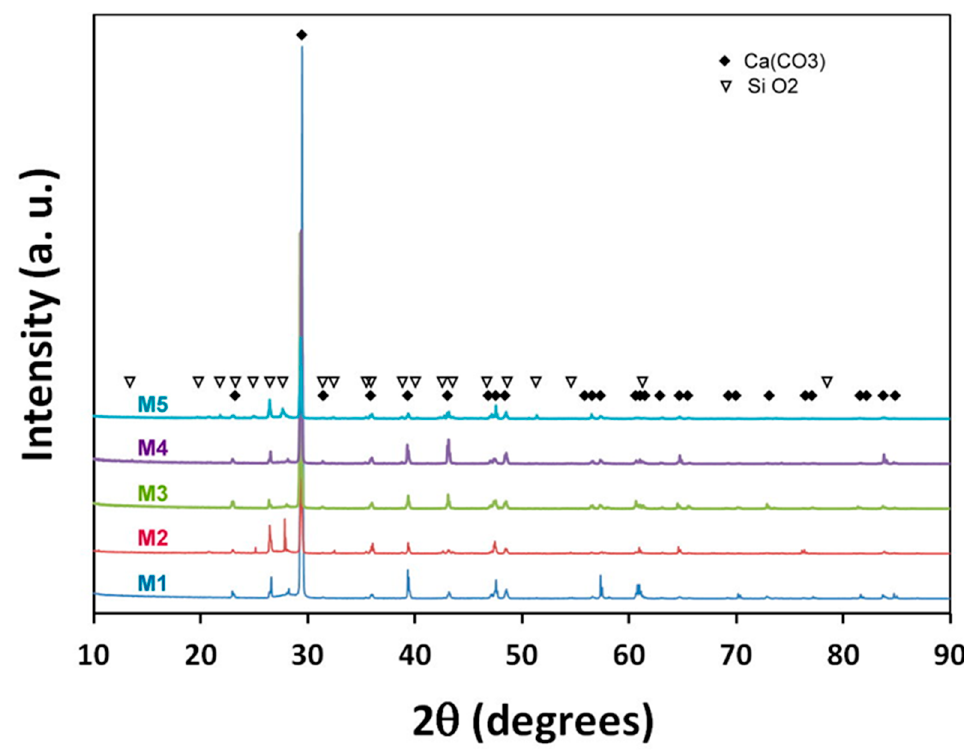
Figure 5. X-ray diffraction pattern confirming the presence of CaCO 3 (black diamond) and SiO 2 (triangle) phase in all samples.